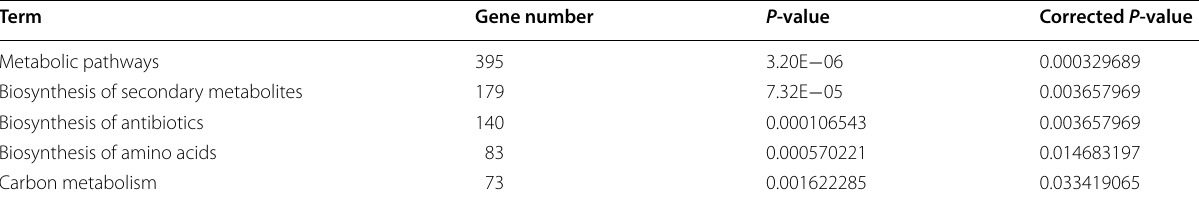
Table 2 Five KEGG pathways related to carbon source in P.